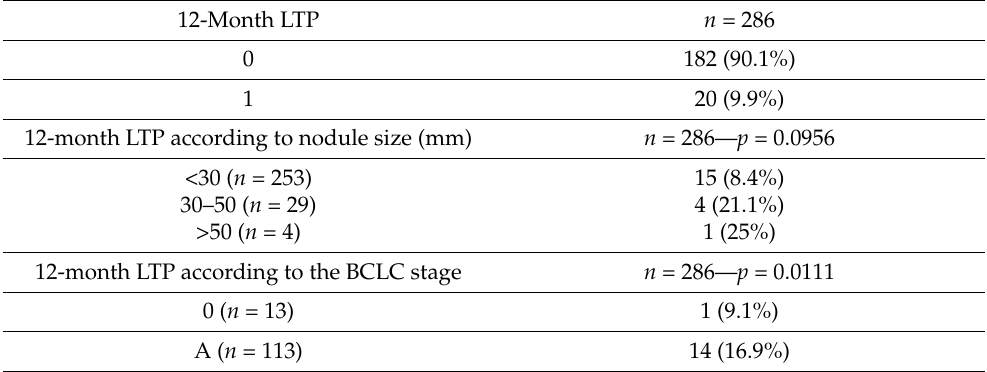
Table 4. Local tumor progression (LTP) and intrahepatic recurrence (IHR) of